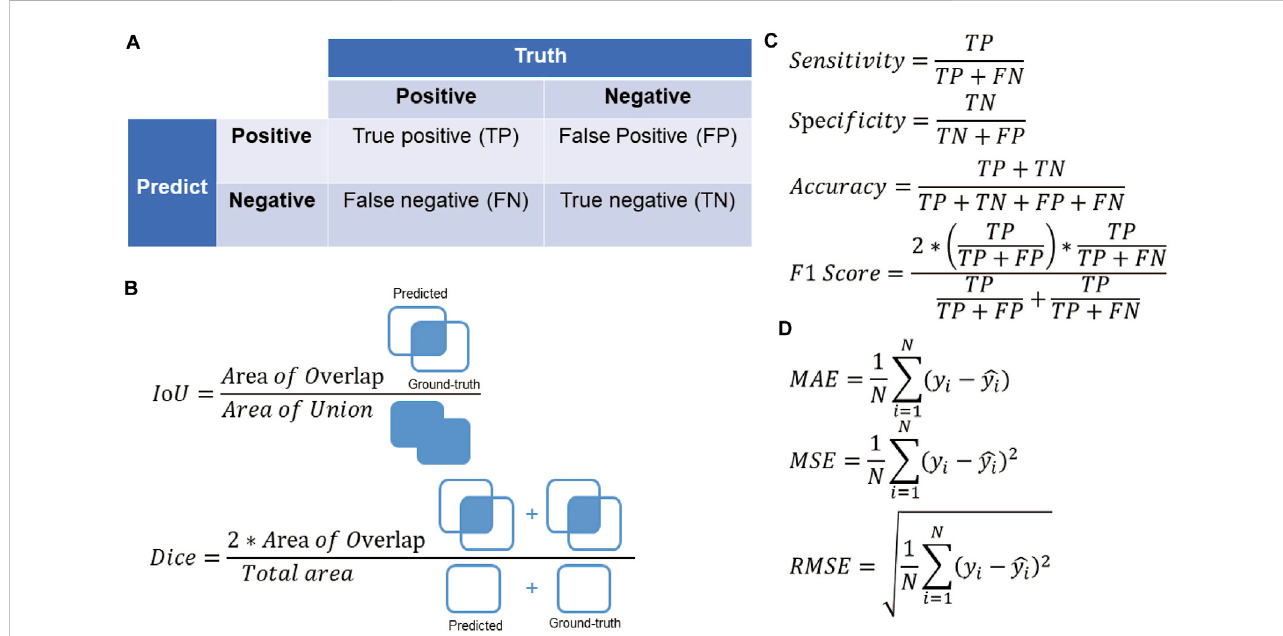
FIGURE 2 (A) The confusion matrix. (B) Evaluation metrics for segmentation tasks in the fi eld of myopia. (C) Evaluation metrics for classi fi cation tasks in the fi eld of myopia. (D) Evaluation metrics for regression tasks in the fi eld of myopia. y i is the ground-truth value of sample i and (cid:1) y i is the predicted value of sample i